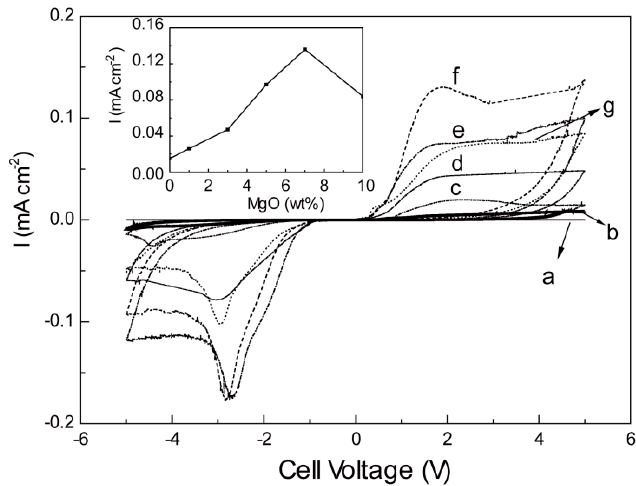
Figure 8. Cyclicvoltammograms (CVs): ( a ) GPE with MgO 0 wt % in the SS/GPE/SS cell; ( b – f ) GPEs with different content of MgO in the Mg/GPE/Mg cell; ( b ) 0 wt %; ( c ) 1 wt %; ( d ) 3 wt %; ( e ) 5 wt %; ( f ) 7 wt %; and ( g ) 10 wt %.